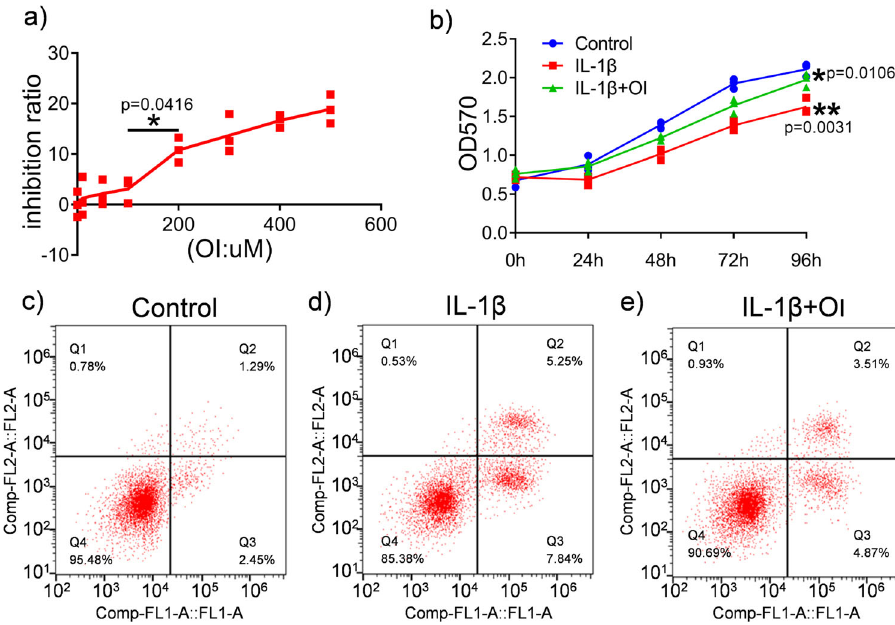
Fig. 1 The effects of OI on C28/I2 cells. a The cytotoxic effects of OI on C28/I2 cells was measured using the MTT assay. The highest concentration at which OI was 100 μ M ( n = 3). The data are the mean ± SD. * P < 0.05. b Cell viability after treatment with OI for 48 h before exposure to 10 ng/mL IL-1 β for 24 h ( n = 3). The data are the mean ± SD. * P < 0.05 IL-1 β + OI group vs. the IL-1 β group, ** P < 0.01 IL-1 β group vs. the Control group. c – e Flow cytometry was utilised to quantify the number of dead cells ( n =